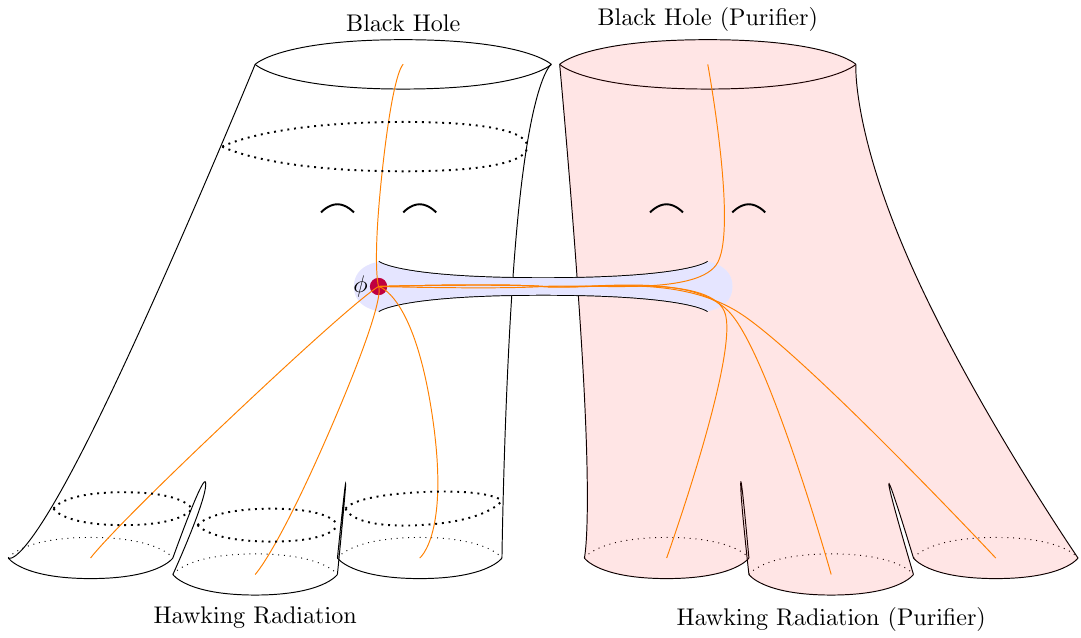
Figure 5 . Schematic picture of flux lines on the geometry corresponding to (2.14) (, similar to the figure discussed in [105]). The dotted lines are horizons. A local operator φ (red dot) is put at the original spacetime (left region). The two spacetimes are connected by the Einstein-Rosen bridge (blue region). Some of flux lines (orange lines) escape into the other spacetime (right red region) through the Einstein-Rosen